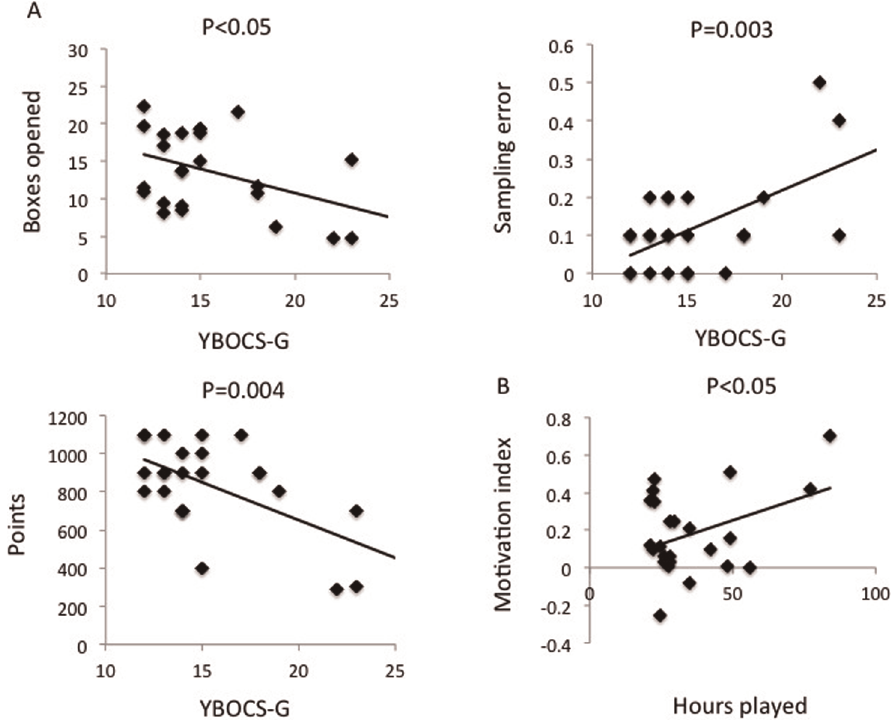
Figure 3. Correlation of severity measures with task outcomes. A. Correlation analyses of video gaming severity based on modified Yale Brown Obsessive Compulsive Scale scores adapted for gambling with Information Sampling Task outcome measures. B. Correlation analysis of video game hours played per week with Motivation Index from the premature responding task.